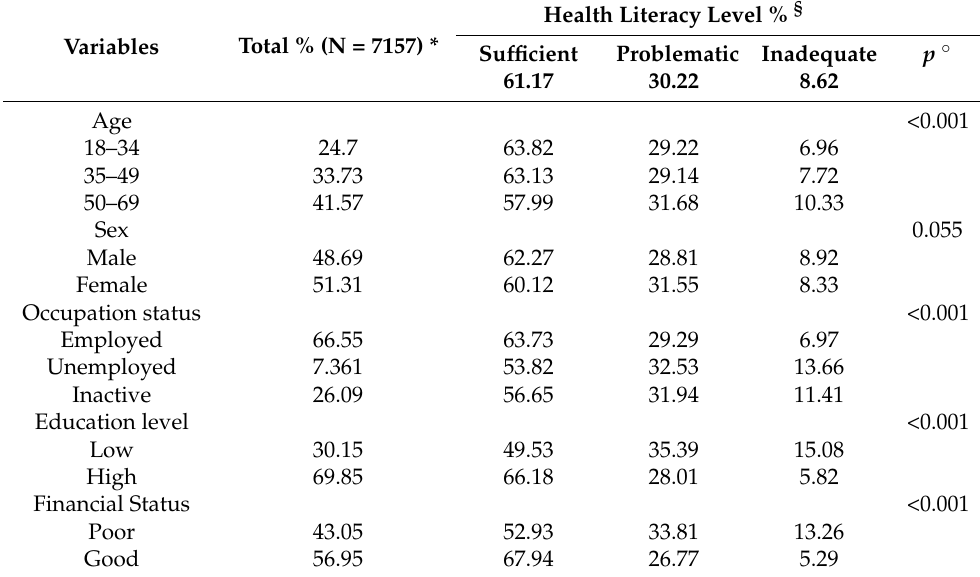
Table 1. Descriptive analysis of collected variables (total sample, subjects with sufficient, problematic and inadequate health literacy